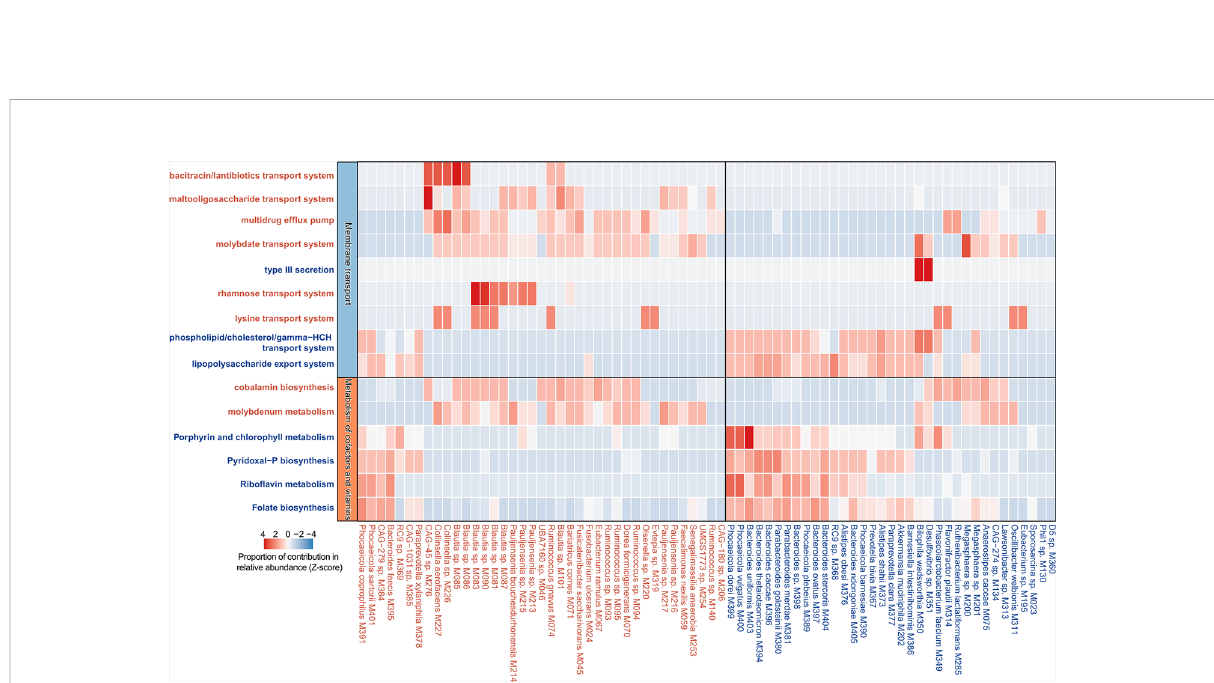
FIGURE 5 Contribution of species on the abundance of functional categories. A heatmap showing the proportional contribution of 74 PE-associated species on the abundance of 15 functional categories shown in Figure 4E. The species that were enriched in the gut microbiota of PE patients and healthy controls are labeled in red and blue, respectively.